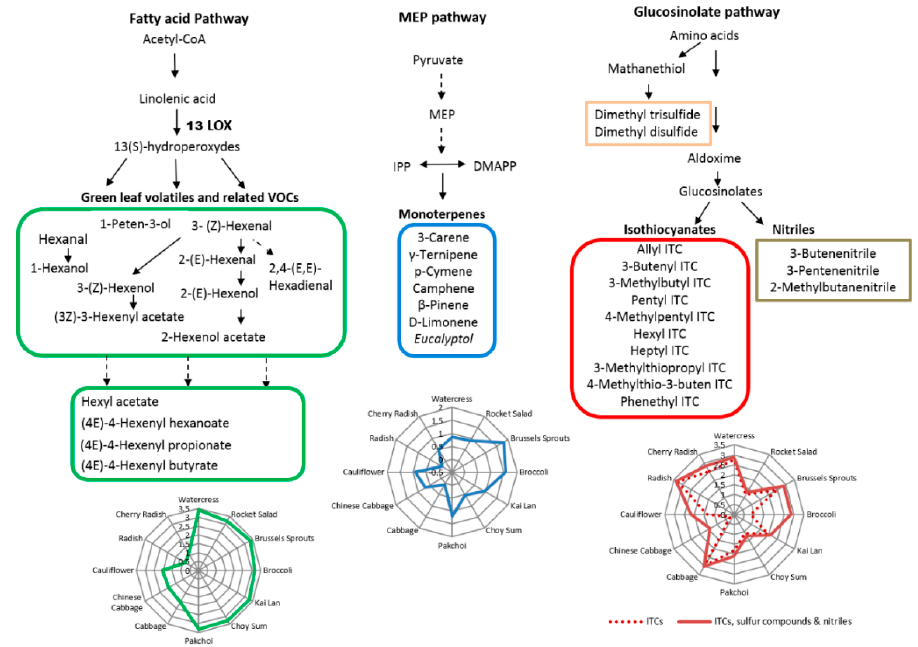
Figure 3. Main metabolic pathways of VOCs and their distribution in 12 Brassicaceae vegetables.